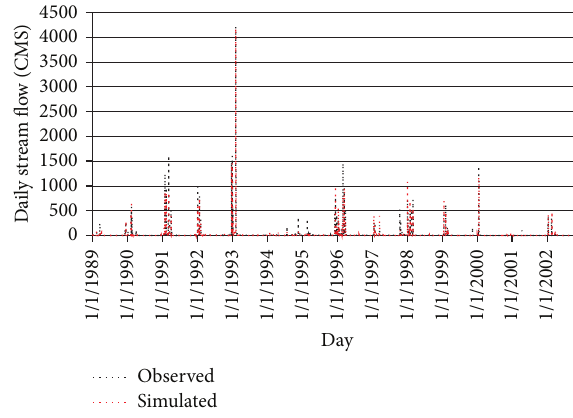
Figure 4: Measured and simulated stream flow (CMS) for training period.